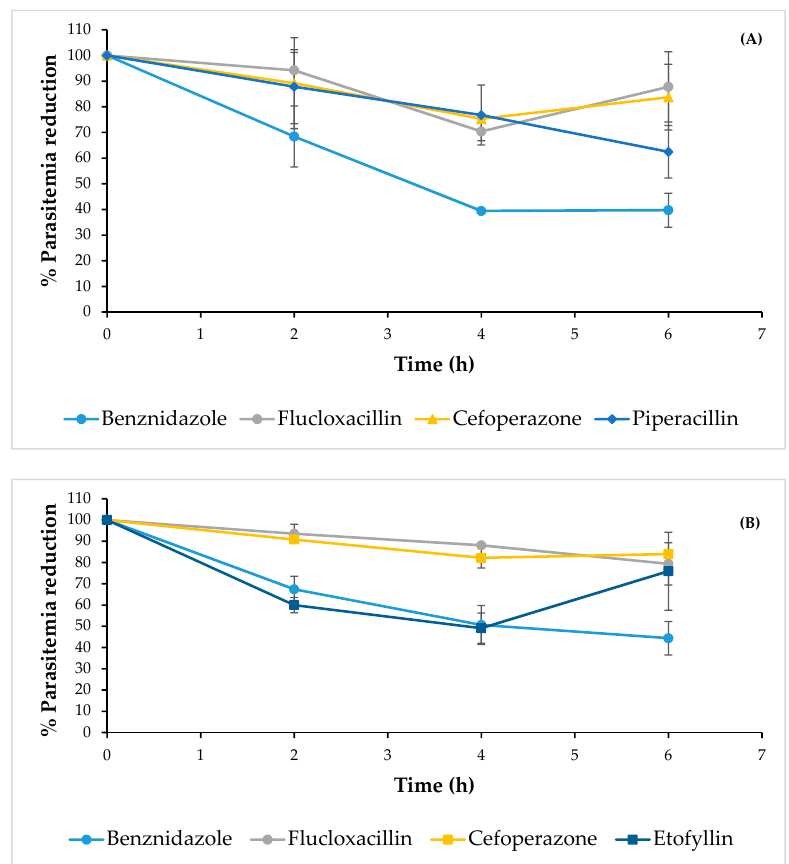
Figure 4. Effects of the compounds in reducing parasites on mice infected with INC-5 ( A ) and NINOA ( B ) strains from T. cruzi over a period of 6 h.